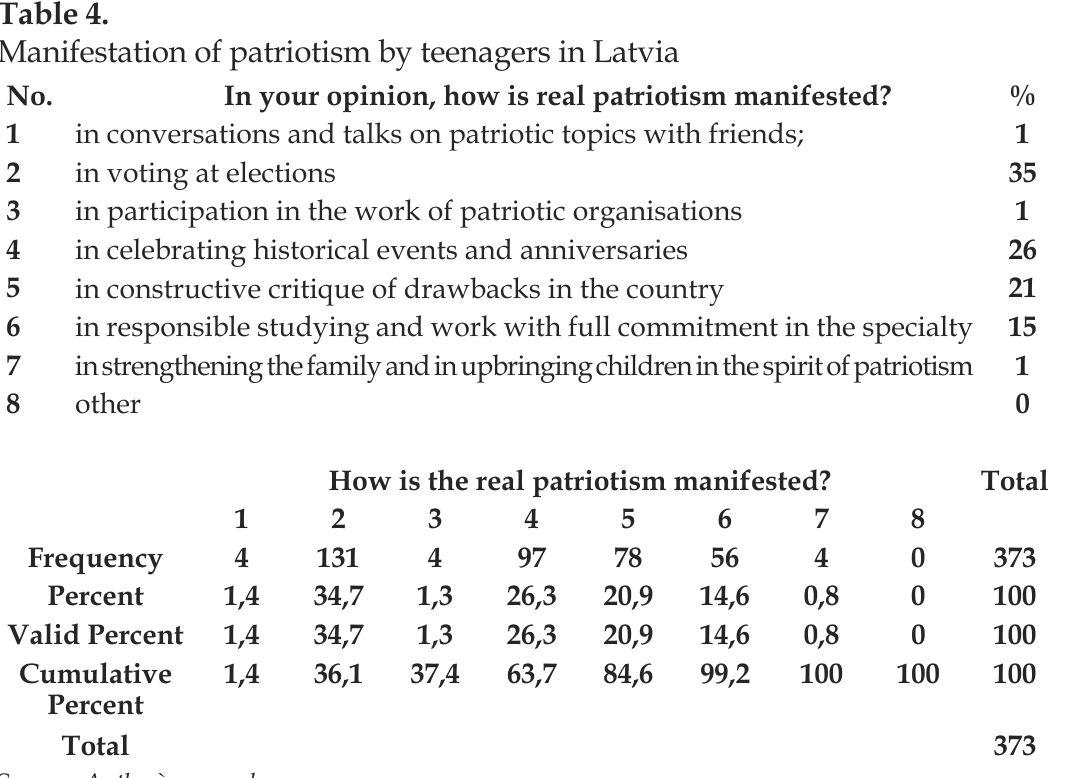
Table 4. No. In your opinion, how is real patriotism